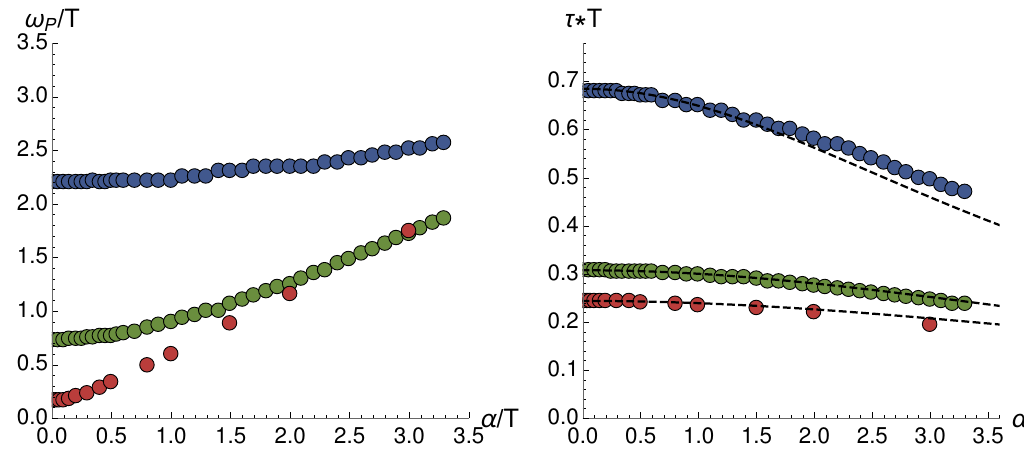
Figure 10 . Evolution of ! P and (cid:28) with increasing (cid:11) for (cid:22)=T = [0 : 2 ; 1 ; 4] (red, green, blue) and (cid:12)xed (cid:21) = 1. The dashed lines are the analytic predictions of (5.2) and (5.3) at small (cid:11)=T (cid:28) 1. The agreement between the data and the analytic correction (5.2) is apparent at (cid:11)=T (cid:28)